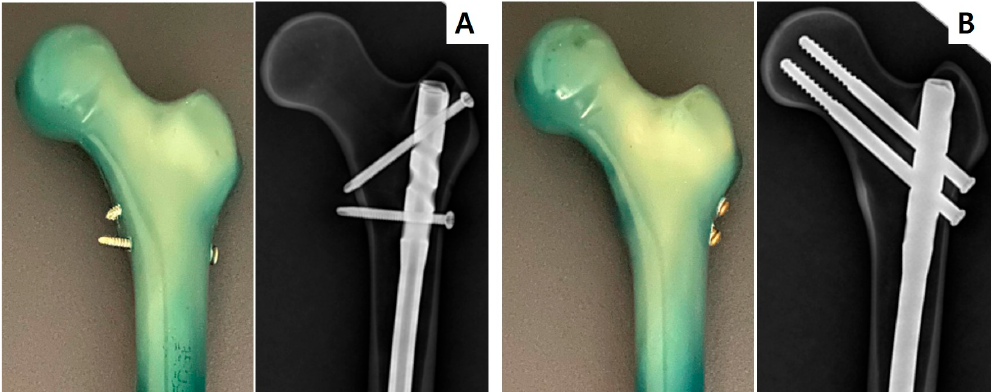
Figure 1. Two different constructs of the osteoporotic femur model with IMN and radiographs: ( A ) IMN with two standard proximal locking screws (SN group) and ( B ) IMN with two reconstruction proximal locking screws (RN group). IMN, intramedullary nailing.